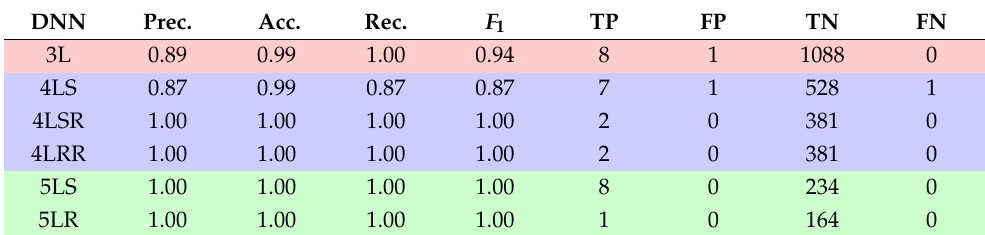
Table 3. Attack 1&2 detection results without measurement